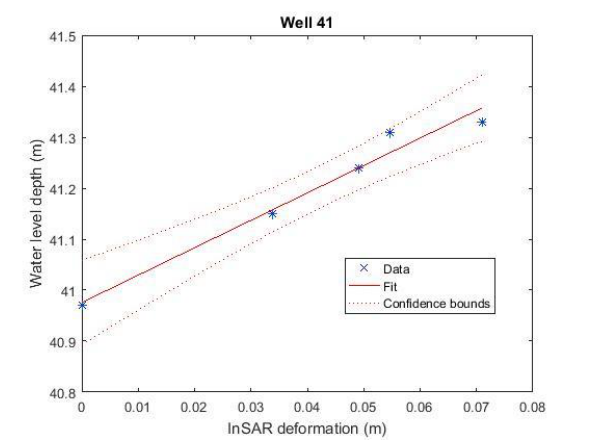
Figure 8. Sample graphs for calculating the skeletal storage coefficient at piezometric wells located in different parts of the subsidence area.